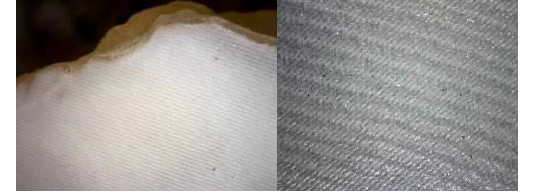
Figure 7. Left: Fine Line ； Right: PR Prototyping Phase 3: This step kept the completeness of rapid prototyping